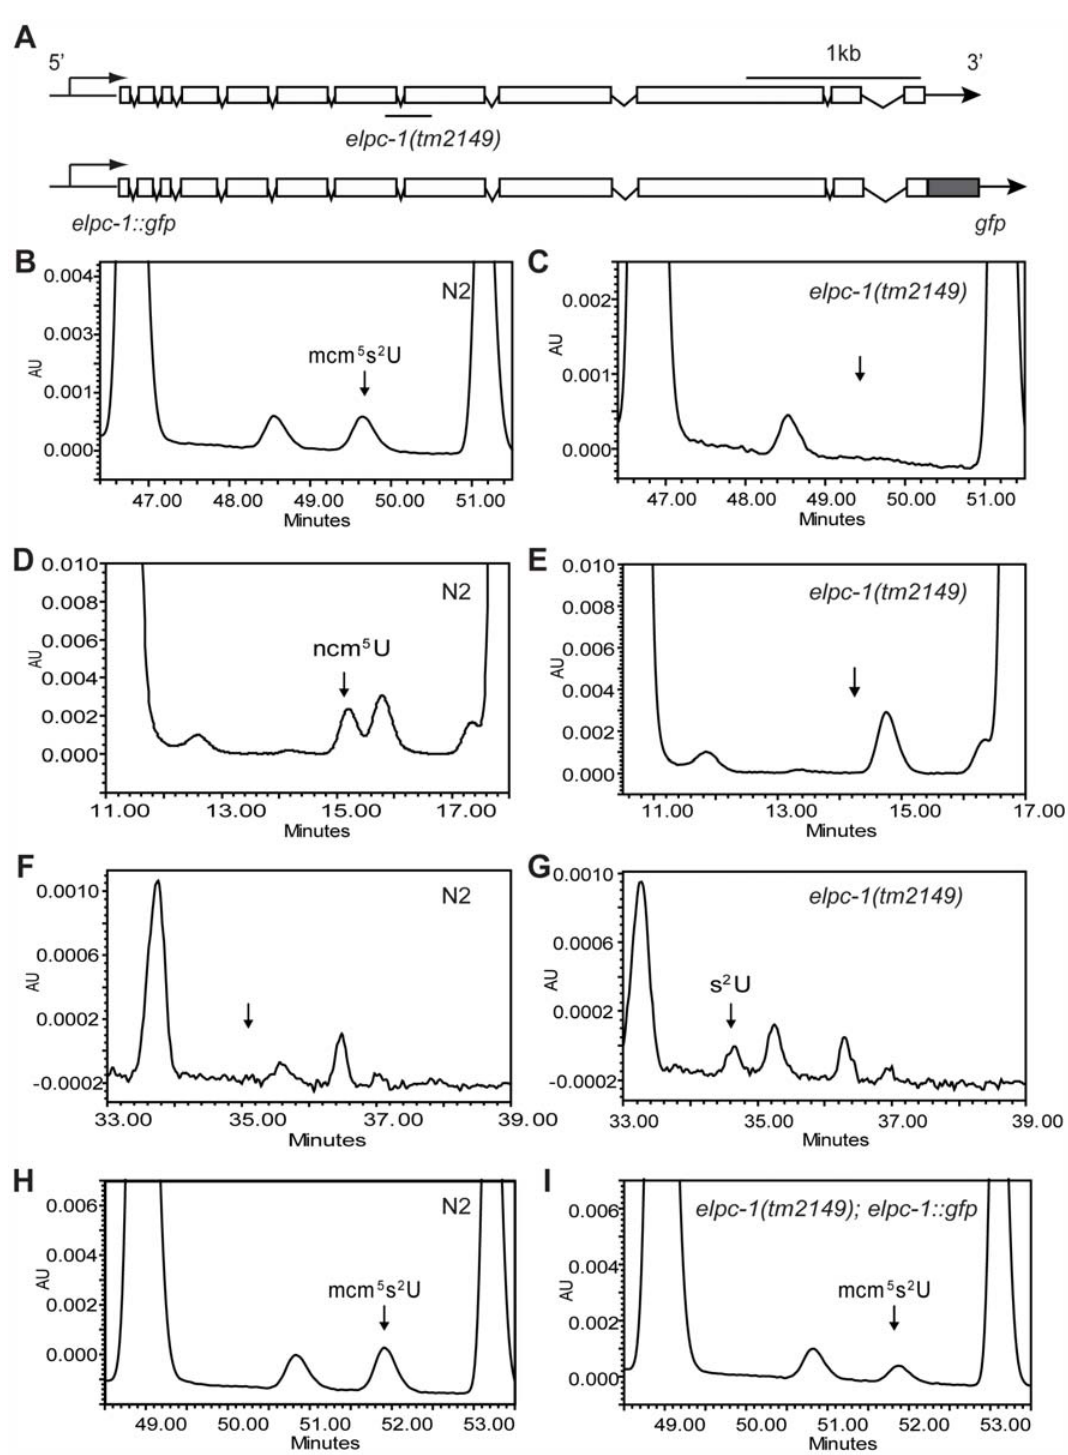
Figure 2. C.eleganselpc-1 is required for mcm 5 and ncm 5 side chain formation at wobble uridines. (A) Schematic drawing of the distribution of exons and introns of elpc-1 . The exons and introns are depicted as boxes and lines, respectively. At top, the line underneath represents the location of the deletion in elpc-1(tm2149) . Below, the structure of the elpc-1::gfp transgene. (B–I) Total tRNA isolated from wild-type and elpc- 1(tm2149) worms was analyzed by HPLC. Wild-type (N2) profiles are shown in the left panels. elpc-1(tm2149) and elpc-1(tm2149) ; elpc-1::gfp profiles are in the right panels. Chromatograms were monitored at 254 nm unless otherwise stated. (B,C) The parts of the chromatograms between retention times 46.4 and 51.5 min are displayed. The arrow in C indicates the expected retention time of mcm 5 s 2 U. (D,E) The parts of the chromatograms between retention times 10.5 and 18 min are displayed. The arrow in E indicates the expected retention time of ncm 5 U. (F,G) The parts of the chromatograms between retention times 33 and 39 min are displayed. The arrow in F indicates the expected retention time of s 2 U. These chromatograms were monitored at 314 nm. (H,I) The parts of the chromatograms between retention times 48 and 54 min are displayed.